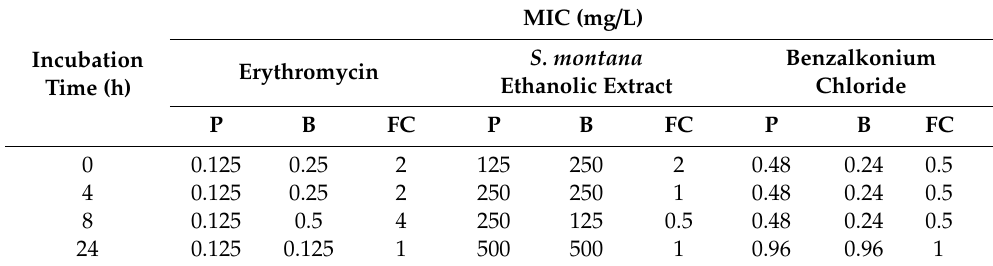
Table 3. Resistance of Campylobacter jejuni 0S6 planktonic and biofilm cells against erythromycin, Satureja montana ethanolic extract and benzalkonium chloride with time of post-harvesting incubation in